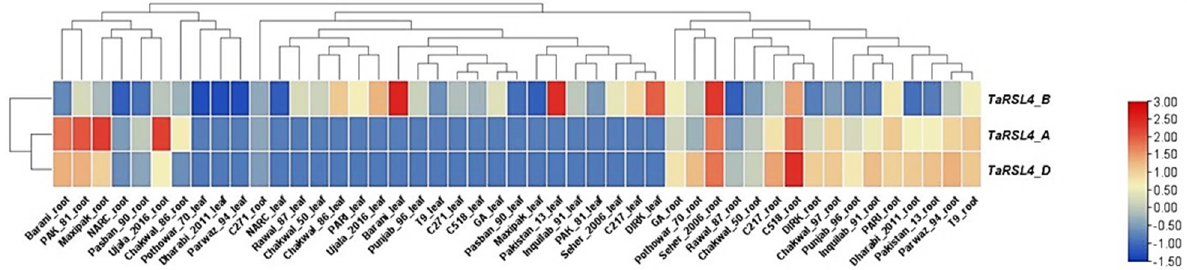
Figure 3. Differential expression patterns of TaRSL4 homoeologues in roots and leaf of twenty-four wheat cultivars as analyzed through wheat cultivars as analyzed through RNA-seq.